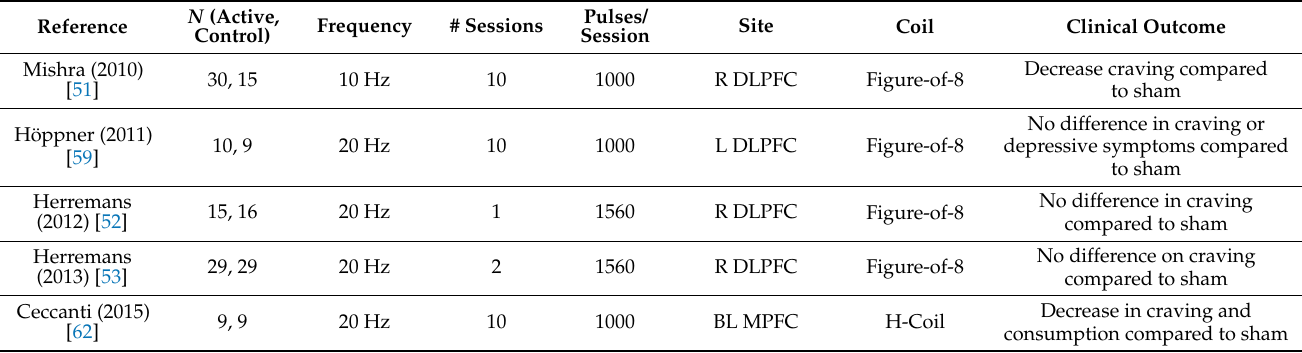
Table 1. Summary of clinical trials of rTMS for